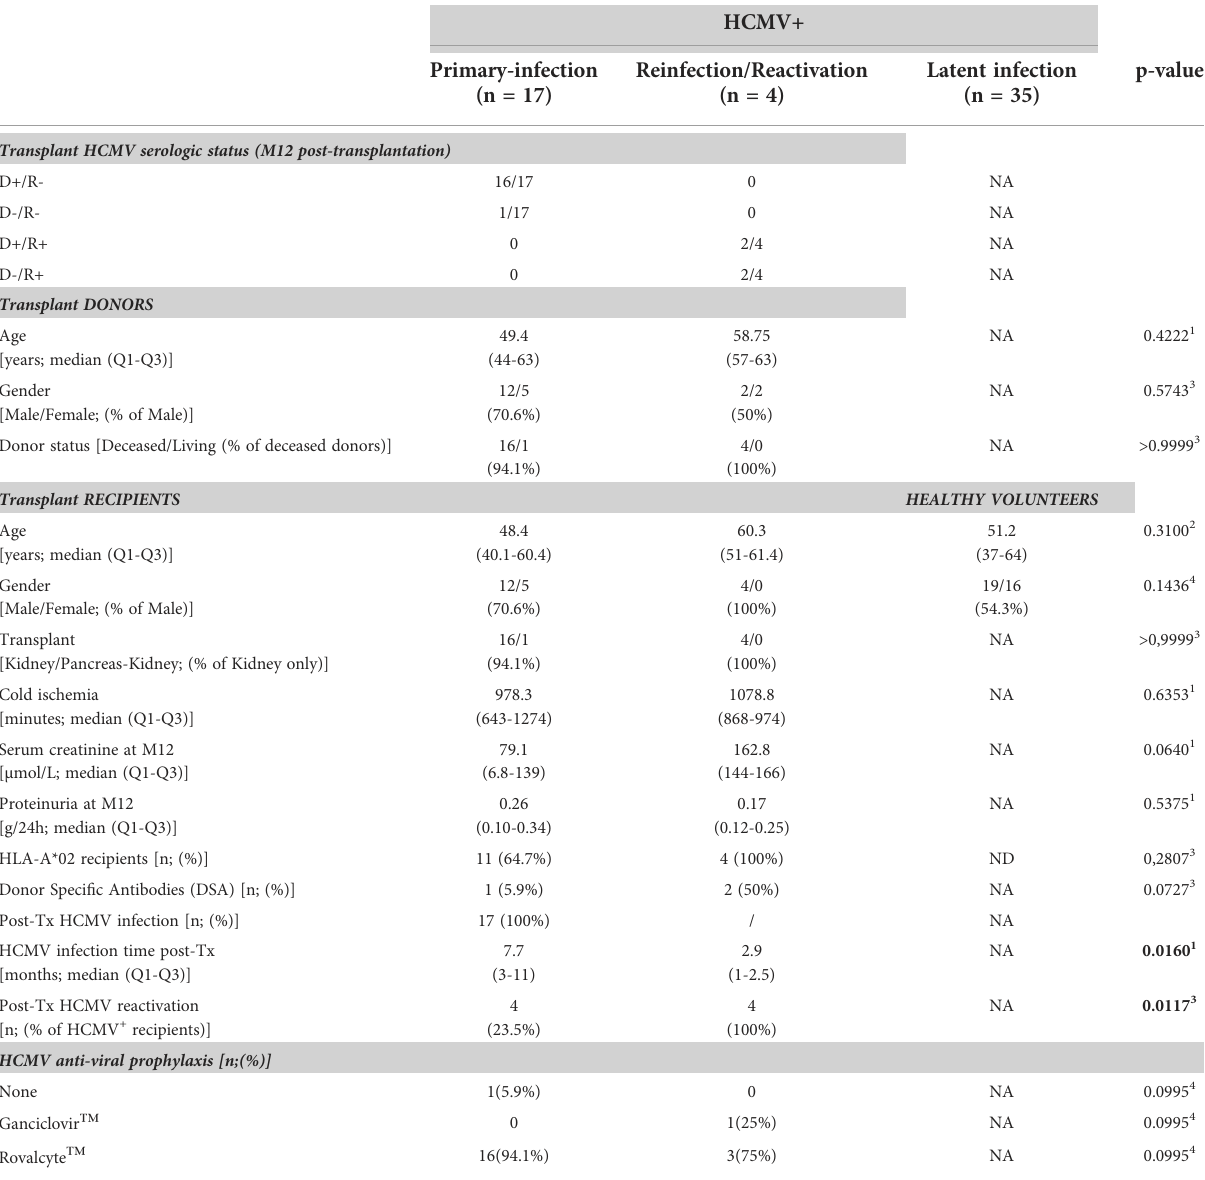
TABLE 1 Characteristics of the HCMV +